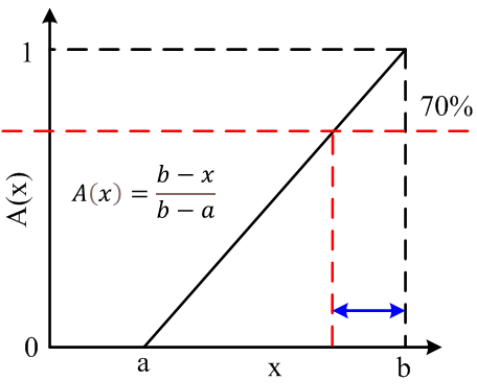
Figure 14. Large membership function.